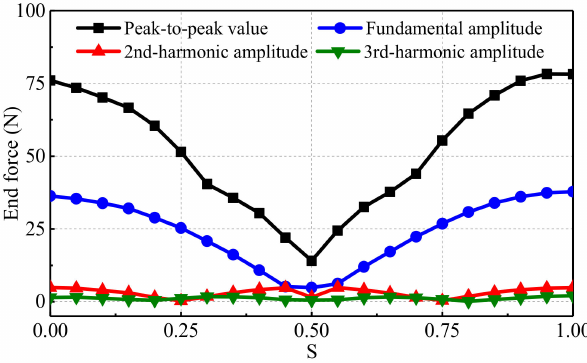
Figure 7. The end force harmonic varying as the shift distance coefficient S